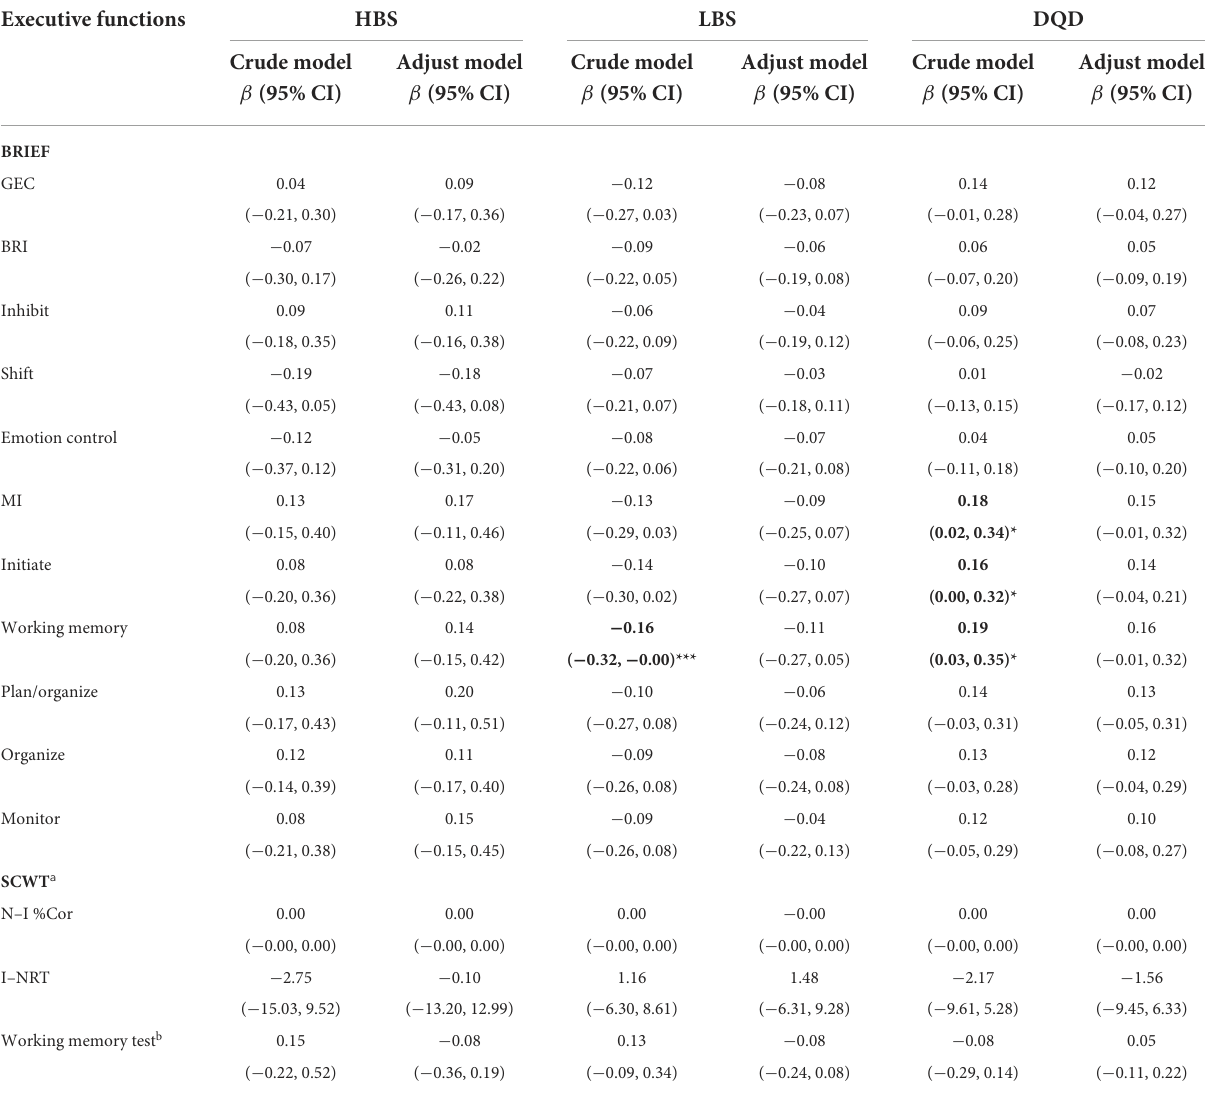
TABLE 3 The association of DBI_16 indicators with executive function in TD